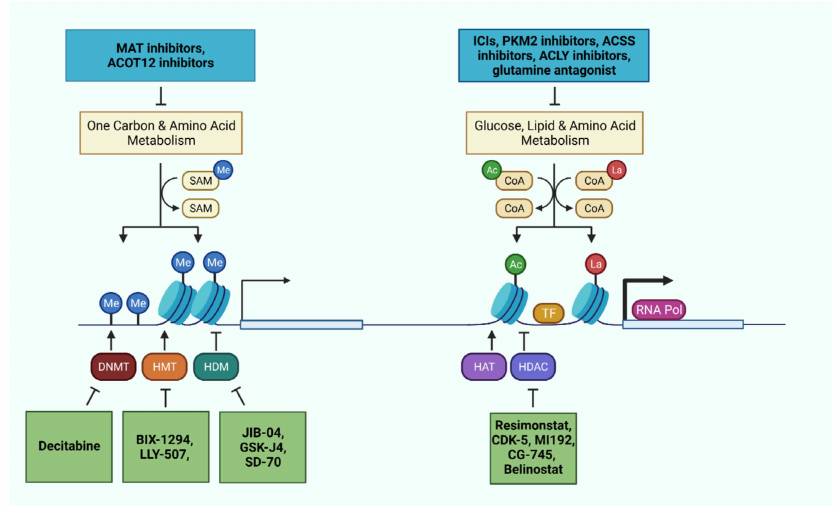
Figure 3. Metabolic and epigenetic machineries as therapeutic targets in liver cancer cells and immune cells. Pharmaceutical interventions targeting relevant metabolic pathways and epigenetic machineries offer the opportunity to impede disease progression, reactivate the immune system, and sensitize the tumor through combinatorial